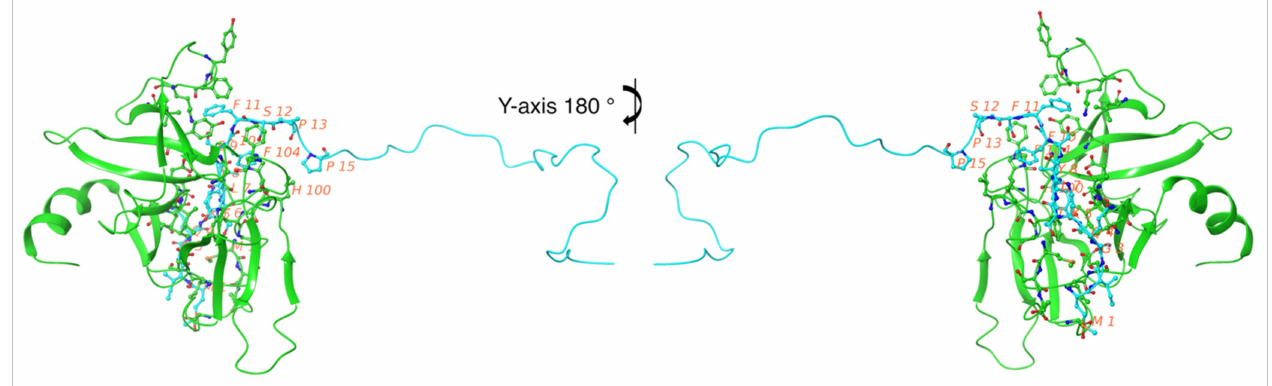
Figure 3. FAM72A-UNG2 (AA1–45) interactions. FAM72A = chain-A is shown in green and UNG2 (AA1–45) = chain-B is shown in blue. The image on the right-hand side is a y -axis 180° of the FAM72A-UNG2 interaction to illustrate the interaction clearly. Key interacting AA residues are labeled in red. The prevalence rate of interface residues on the FAM72A-UNG2 interaction has been depicted by molecular rendering (cartoon model). Hydrophobicity is the major phenomenon of the FAM72A protein and UNG2 peptide interaction.